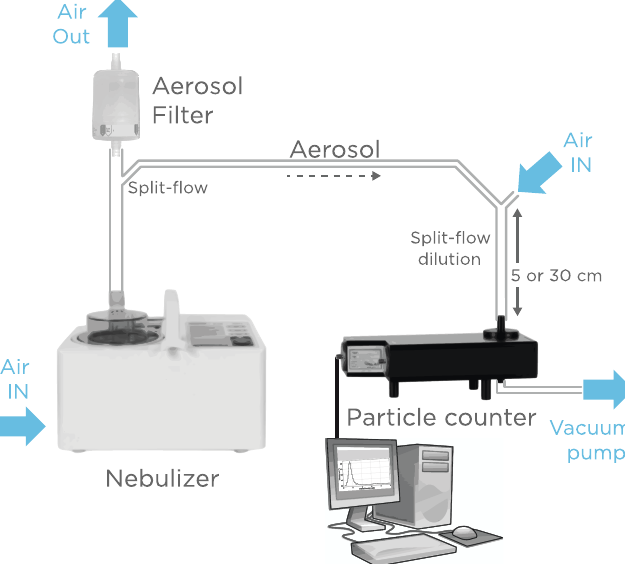
Figure 1. An aerosol generating system connected to a particle counter was used to characterize aerosols. Particles generated by aerosolizing a test solution using an OMRON nebulizer were mixed with air and sized with a Welas particle counter.